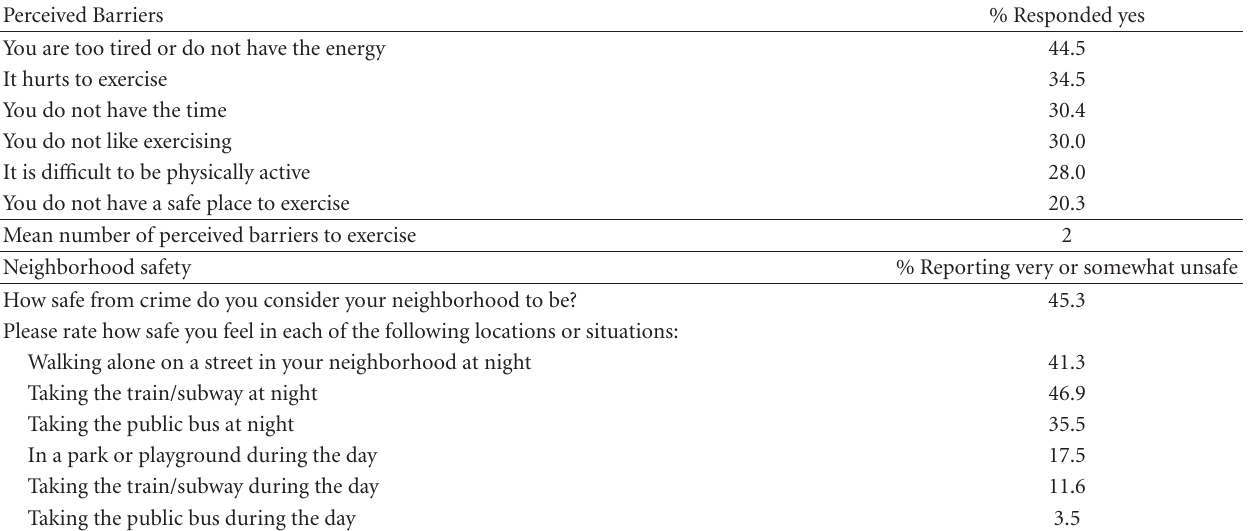
Table 3: Perceived barriers to physical activity and neighborhood safety.